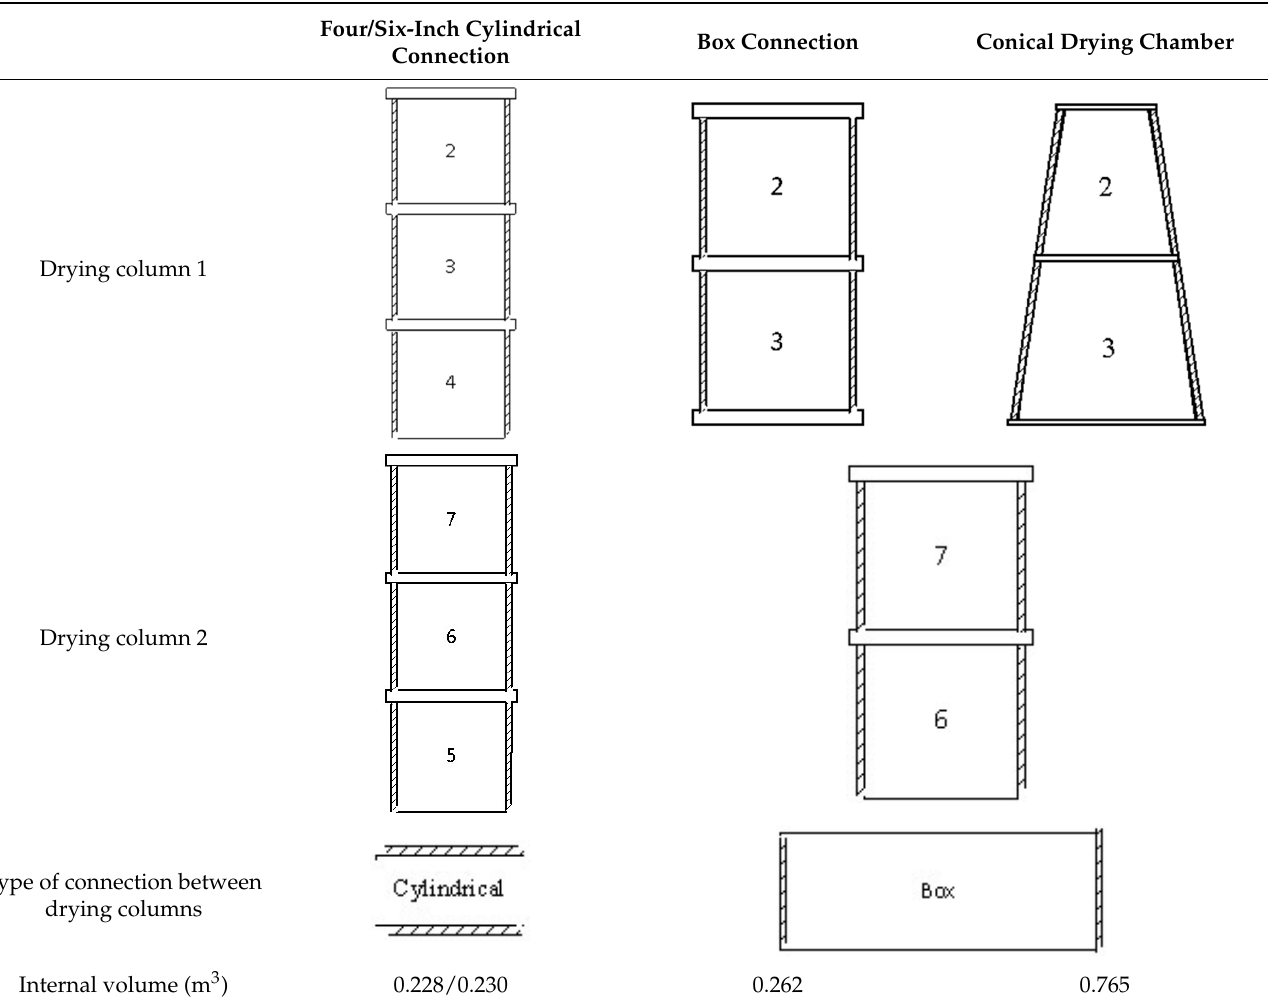
Figure 2. Spray dryer with cylindrical drying chamber and box connection (Design 3) [22].